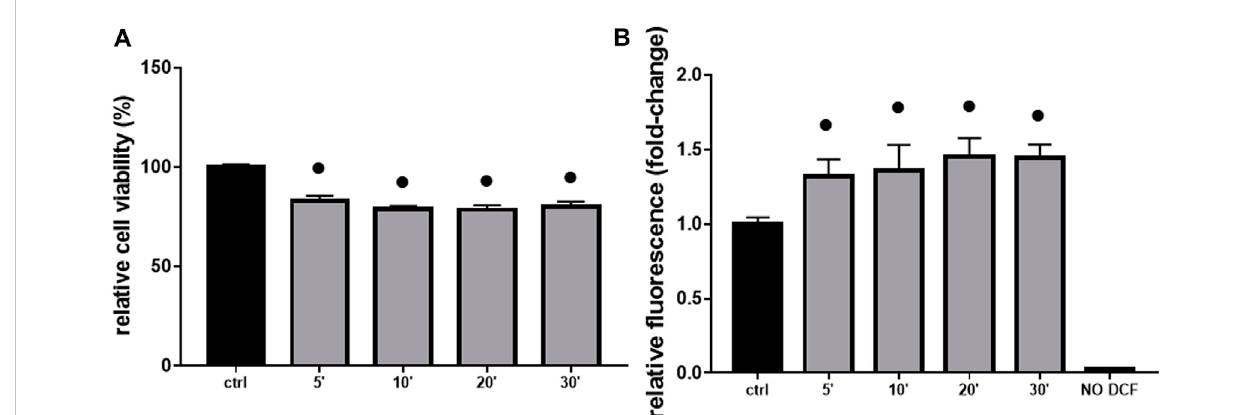
FIGURE 4 Cell viability & ROS production. The fi gure shows the relative histograms obtained from: (A) MTT and (B) DCF-DA assays. H9c2 cells were treated with 10 mM of glyphosate at different time points (from 5 to 30 min). After the treatments, cell viability and ROS production were assessed, respectively, through MTT and DCF-DA assays. Mean ± SD; p -values: C < 0.0001 vs . control. NO DCF: control lane without the fl uorescent